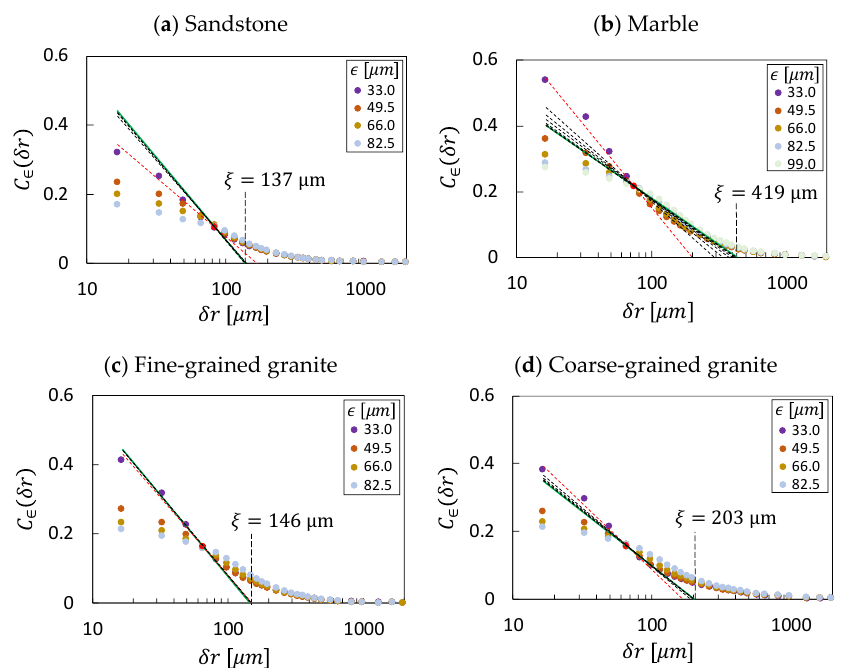
Figure 3. Spatial correlations of ω 𝜖 for sandstone (a), marble (b) fine-grained granite (c), and coarse grained granite (d). The correlations are represented for ω 𝜖 computed at different scales 𝜖 . The true cutoff length 𝜉 is represented for each case. Dashed red lines are showing the initial guess for estimating 𝜆 𝑐 ; green solid lines are passing through the point of convergence (red points) and the true 𝜉 with the slope 𝜆 𝑐 = 𝜆 𝑖 𝑐⁄ ; and black dashed lines are showing different iterations that are converging to the green lines.